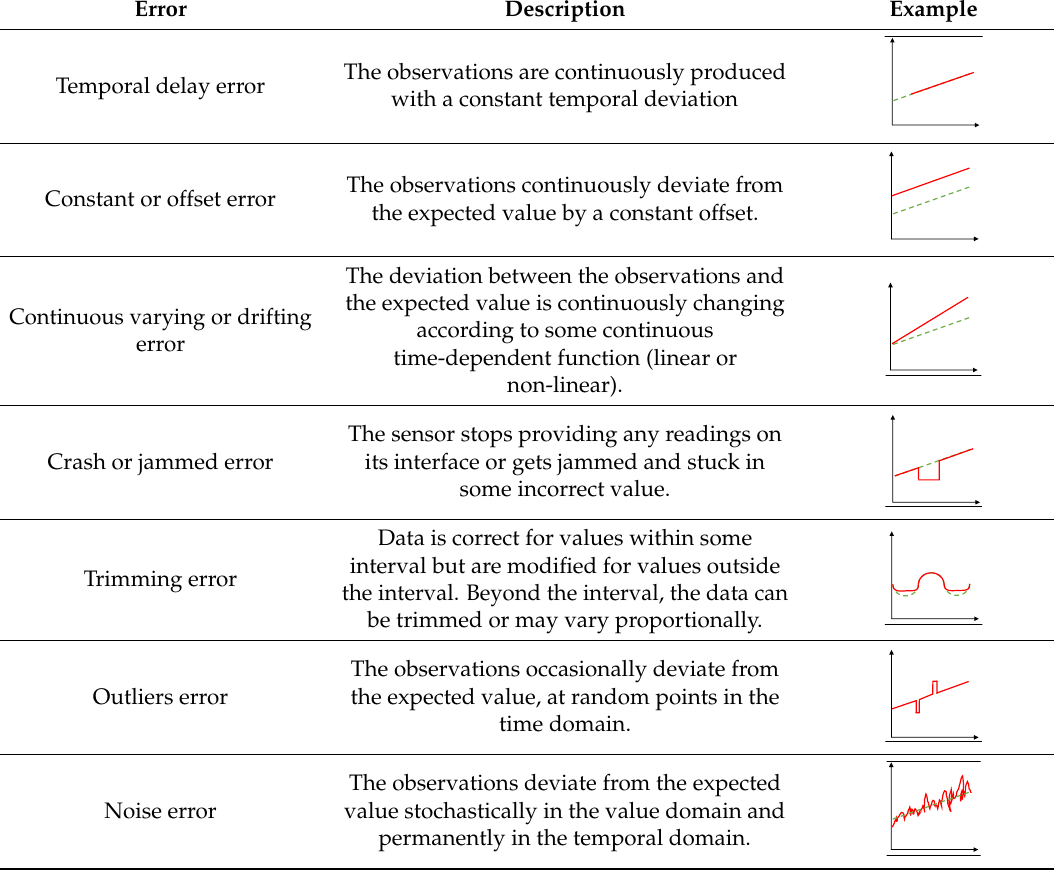
Table 2. Sensors errors deriving DQ problems in SCP environments (adapted from [8]).